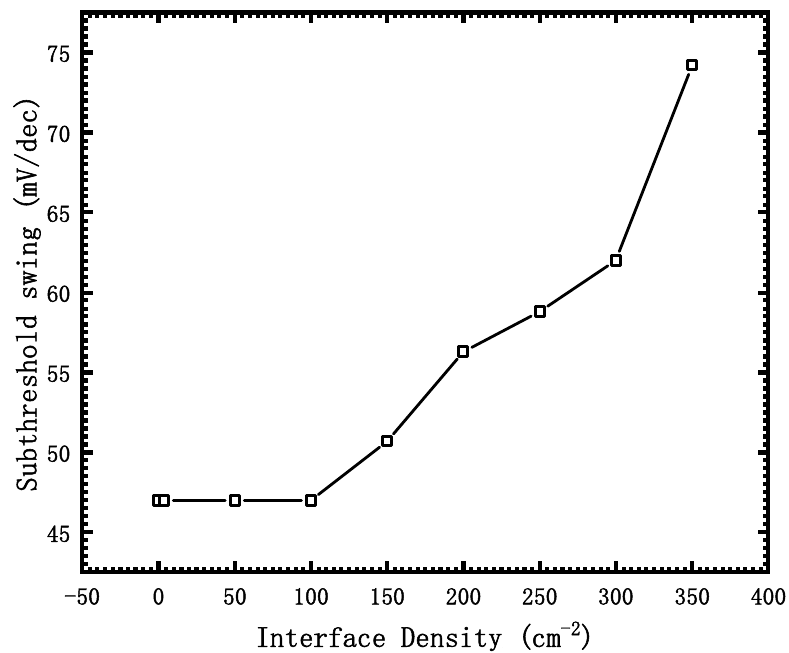
Figure 7. Subthreshold swing with different Interface Density.